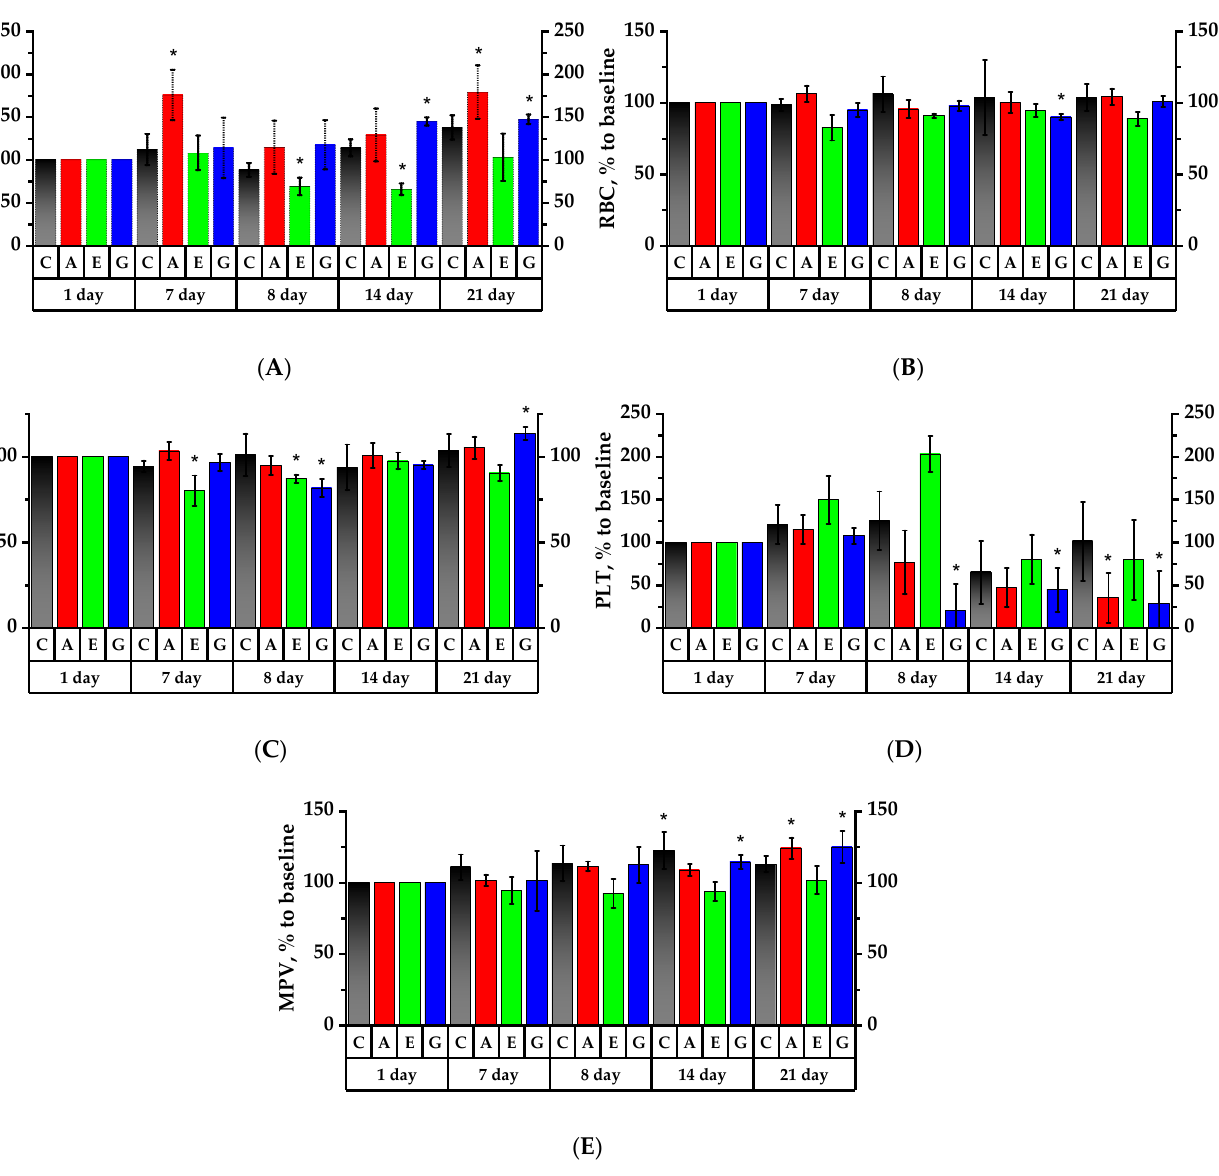
Figure 4. Main hematology results for whole blood of lab animals. The corresponding baselines for each group on the 1st day of the experiment are taken as 100%. ( A ) White blood cell (WBC) count; ( B ) red blood cell (RBC) count; ( C ) hemoglobin (HGB) concentration; ( D ) platelet (PLT) count; ( E ) mean platelet volume (MPV). * p < 0.05, significance of differences in animal groups compared to the 1st day of the experiment.